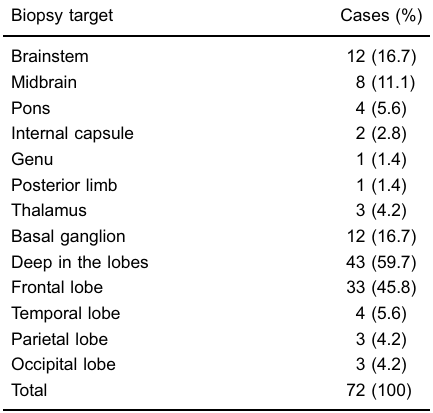
Table 1. Distribution of target sites for biopsy in 72 brain lesions. Biopsy target